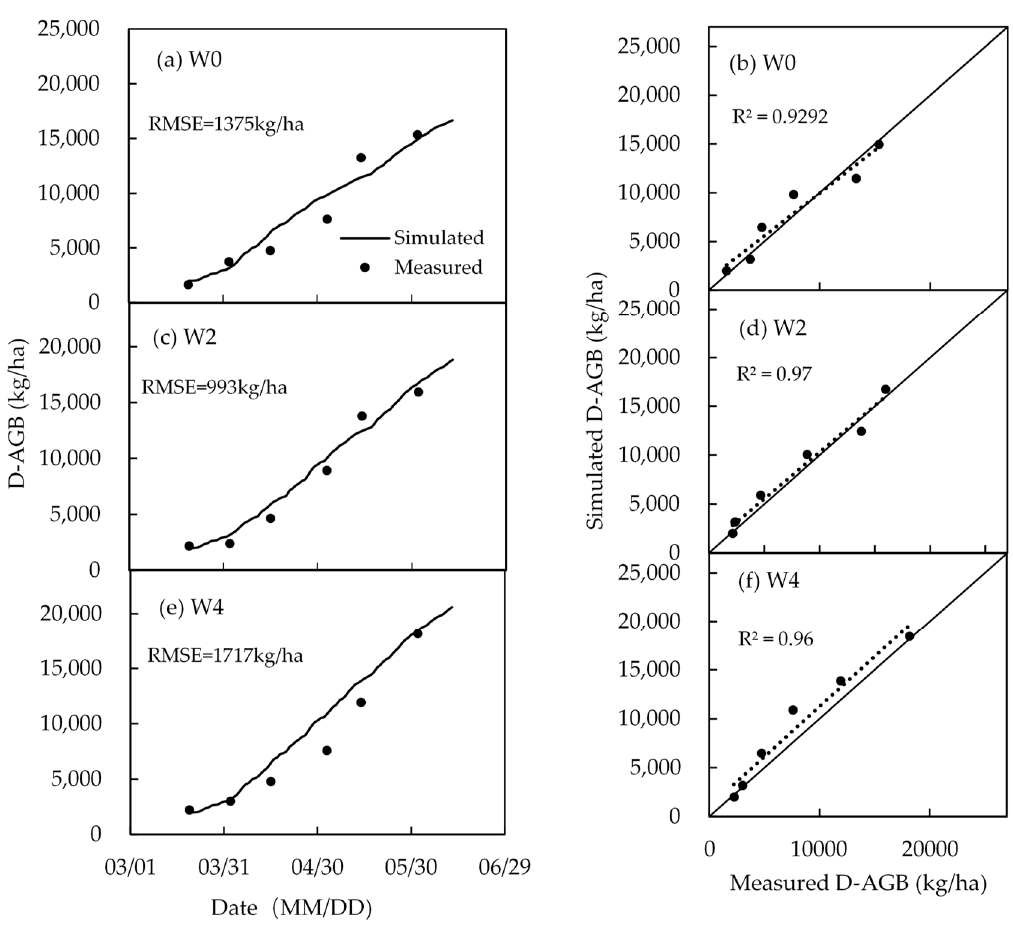
Figure 14. Comparison of measured and simulated above-ground dry biomass in calibration treatments.